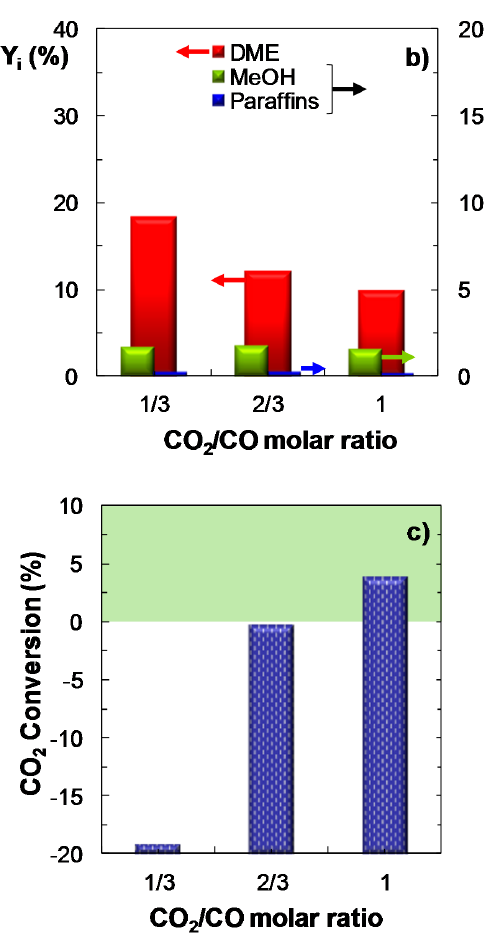
Figure 6. Effect of CO 2 /CO molar ratio in the feed on the conversion of CO x ( a ); Product yield ( b ); CO 2 conversion (or CO 2 yield, for negative values) ( c ). Reaction conditions: Feed, H 2 + CO + CO 2 with H 2 /CO x molar ratio of 3; 275 ◦ C; 30 bar; 10 g cat h (mol C ) − 1 .